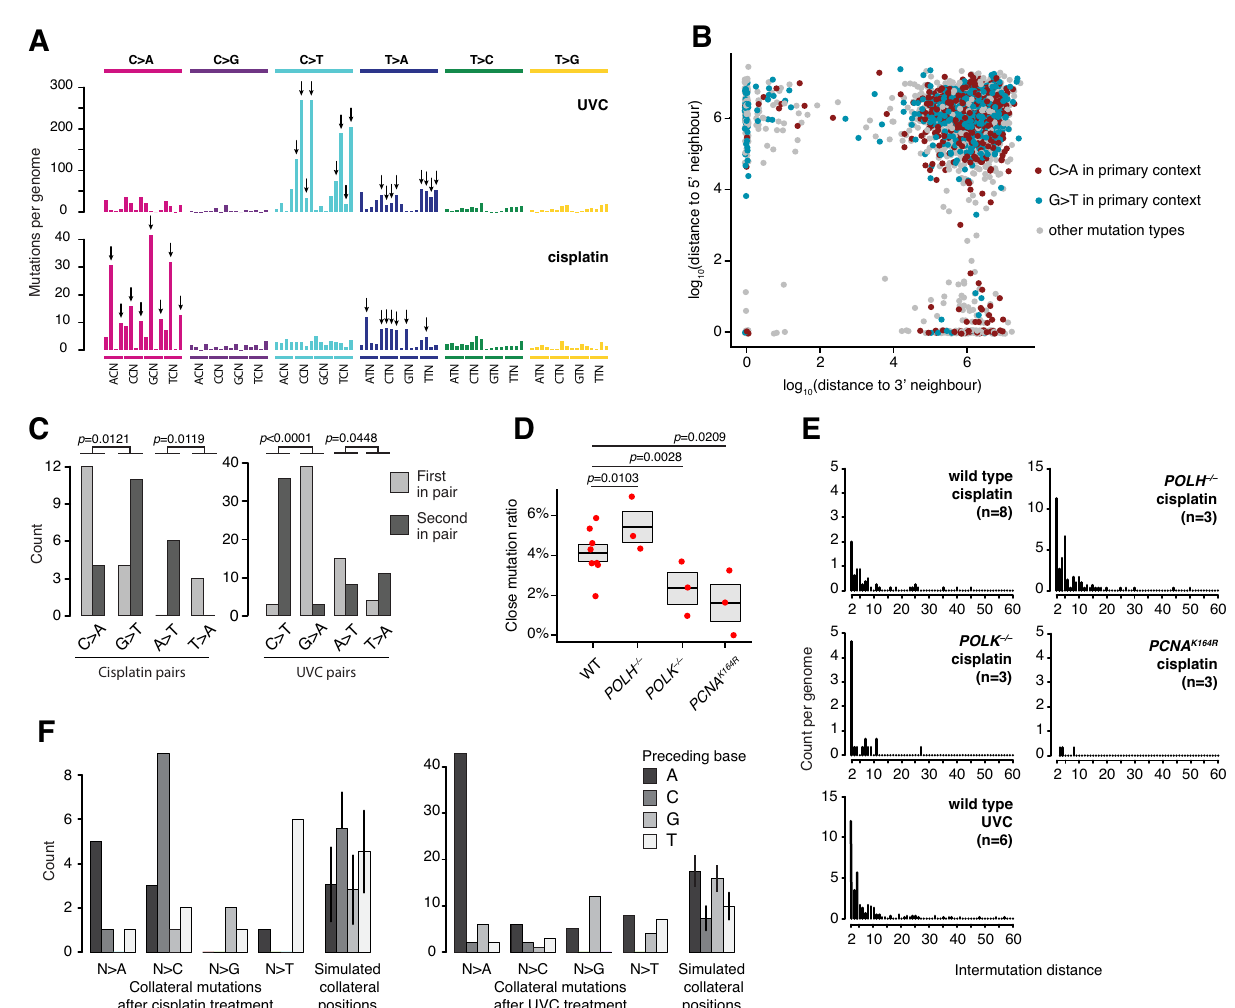
Fig 2. Characterisation of cisplatin- and UVC-induced collateral mutagenesis. (A) Mean triplet mutation spectra of wild type cells treated with cisplatin and UVC. Each point mutation class, as indicated by the colours and the top bars, are further classified by the identities of the preceding and the following bases, sorted alphabetically. Primary mutations arising directly at the lesion sites are marked with black arrows. (B) 2D rainfall plot of all cisplatin-induced mutations in wild type cells. Each point represents a mutation, coloured by its primary mutation status and identity of C > A or G > T. Position along the x -axis indicates the distance to the next 5’ mutation in the same sample, while position along the y -axis indicates the distance to the nearest 3’ substitution. Note the different dominant colour based on the direction of a near neighbour. (C) Association of primary mutation types with relative positions inside close mutation pairs in cisplatin- and UVC-treated samples. Relative position inside pairs refer to whether a given mutation is the first or the second mutation in a pair, as detected on the upper (5’-3’) genomic strand. C/G > A/T, A/T > T/A mutations (in case of cisplatin) and C/G > T/ A, A/T > T/A mutations (in case of UVC) are significantly enriched in the 3’, or first positions of the pairs (Fisher’s exact test). (D) Close mutation ratios of cisplatin-treated TLS mutant cell lines. Red markers show the ratios for individual clones, boxes show the means and standard errors. The significance of differences to the WT values are shown (two-sample proportion test) (E) Intermutation distance distributions of cisplatin- or UVC-treated wild type and cisplatin-treated TLS mutant cell lines. (F) Collateral mutations have a tendency to copy their immediate neighbour towards the original lesion. Collateral mutations are categorised by the variant allele (column groups) and shaded by the identity of the previous base towards the primary mutation. The rightmost categories show the distribution of previous bases for simulated collateral events around the solitary primary mutations. The simulation used the intermutational distance distributions detected in wild type cells (E) and were run 100 times with a set size equal to the number of analysed close pairs, error bars represent SD.